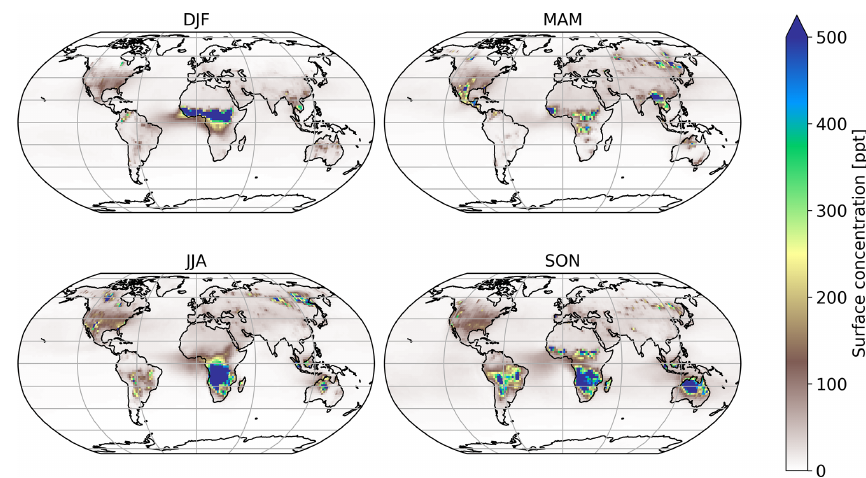
Figure 4. Mean seasonal surface concentration of HNCO using Koss et al. (2018) biomass burning emission factors.